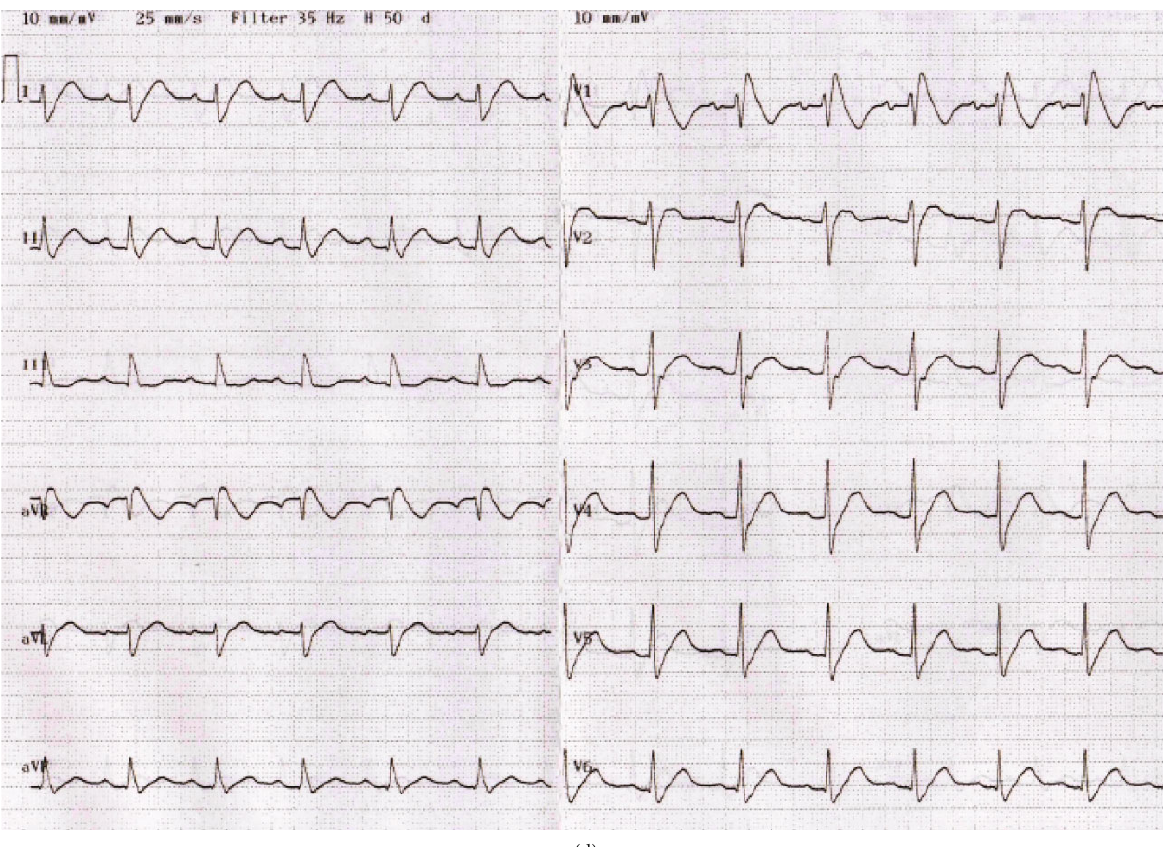
Figure 1: (a) ECG analysis of patient MMRL 1126 showing early repolarization phenotype. A prominent ST segment elevation and slurring of the QRS complex is apparent in several leads. (b) Infusion of dobutamine caused the appearance of monomorphic VT in MMRL1126 which persisted after dobutamine was discontinued. (c) The arrhythmogenic focus was ablated and patient subsequently exhibited RBBB apparent in lead V1. (d) Patient was challenged with ajmaline resulting in unmasking of